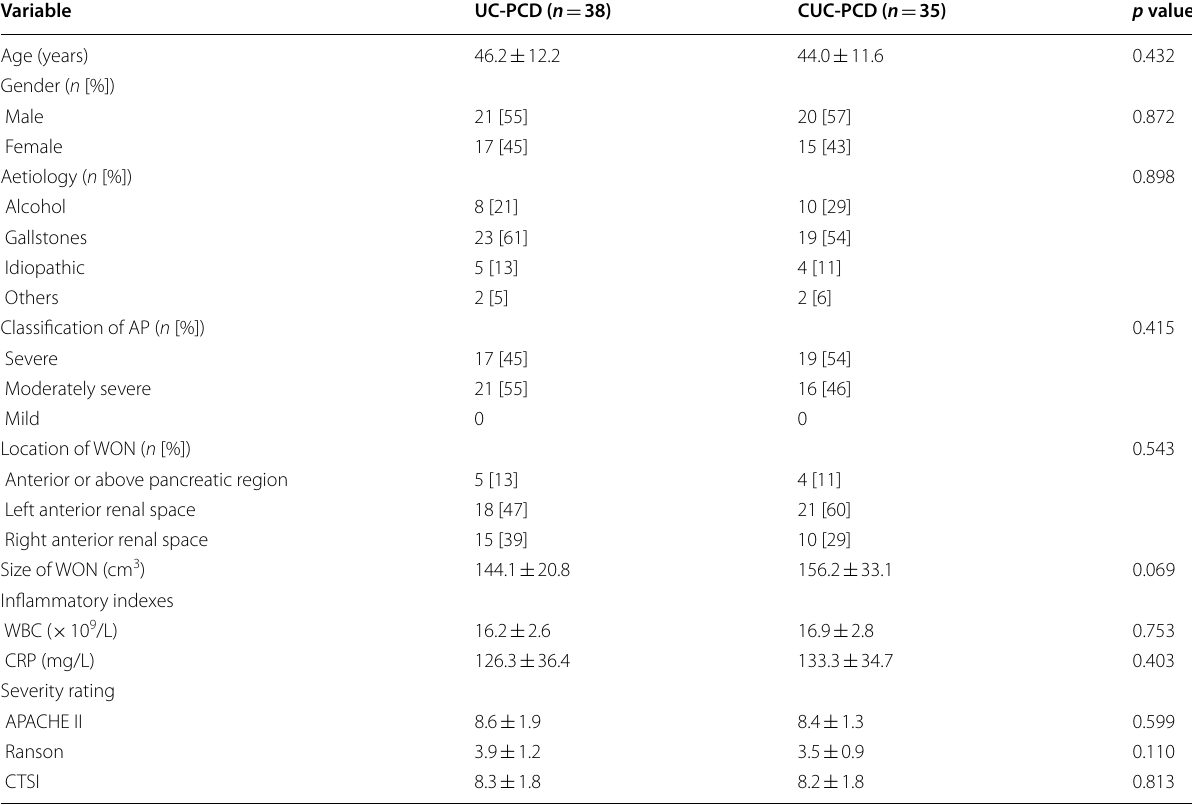
AP, acute pancreatitis; WON, walled-off necrosis; WBC, white blood cells; CRP, C-reactive protein; APACHE, acute physiology and chronic health evaluation; CTSI, computed tomography severity index